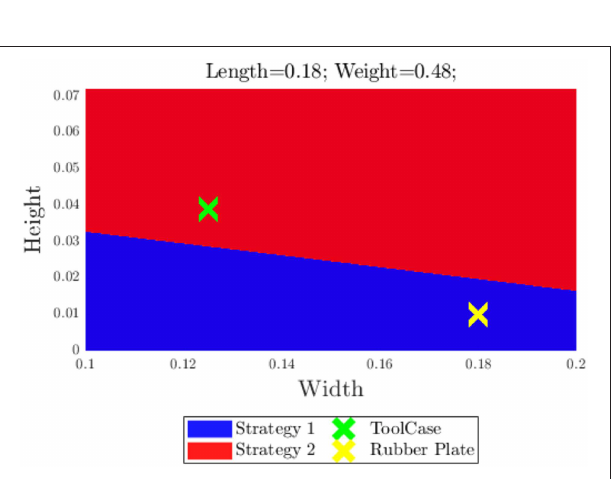
FIGURE 14 | Prediction of best strategy for two test